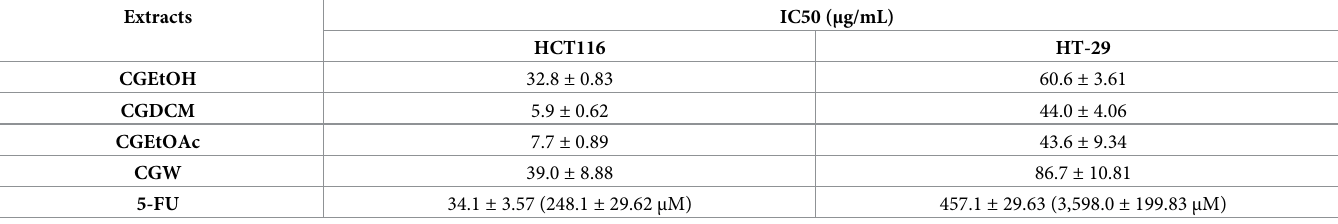
Abbreviations: CGEtOH, C . gigantea ethanolic extract; CGDCM, C . gigantea dichloromethane extract; CGEtOAc, C . gigantea ethyl acetate extract; CGW, C . gigantea water extract; 5-fluorouracil,